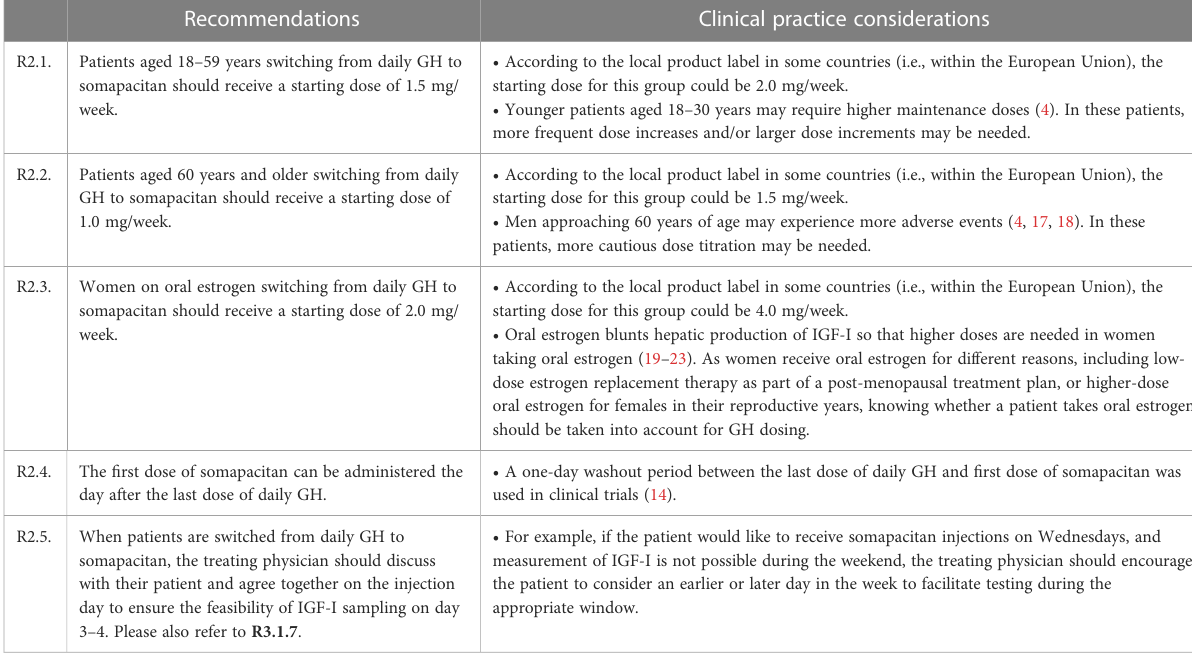
TABLE 2 Recommendations for somapacitan therapy in AGHD patients switching from daily GH to somapacitan. Recommendations